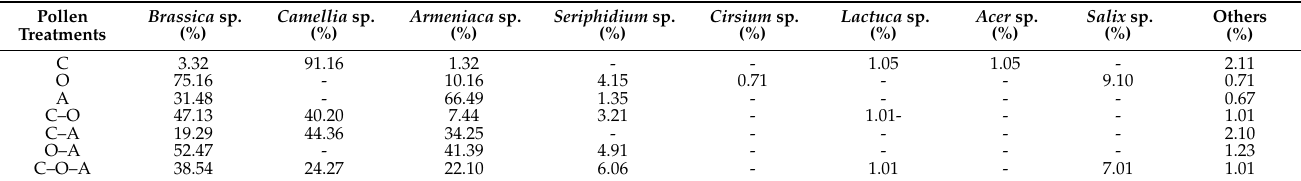
Table 1. The composition and percentage of the pollen treatments.